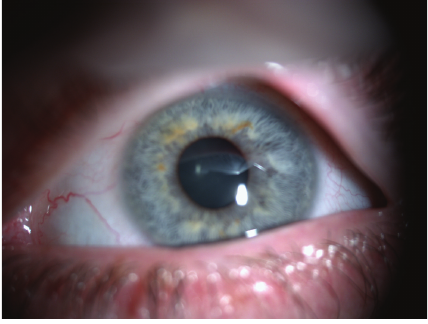
Figure 4: One month after